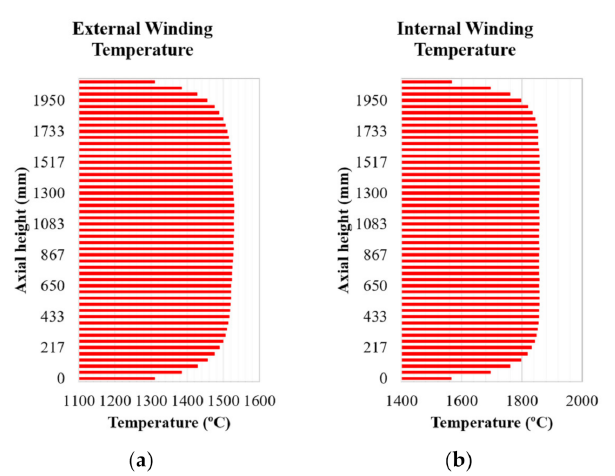
Figure 15. Temperatures inside the transformer during a short-circuit ( a ) in external winding, ( b ) in internal